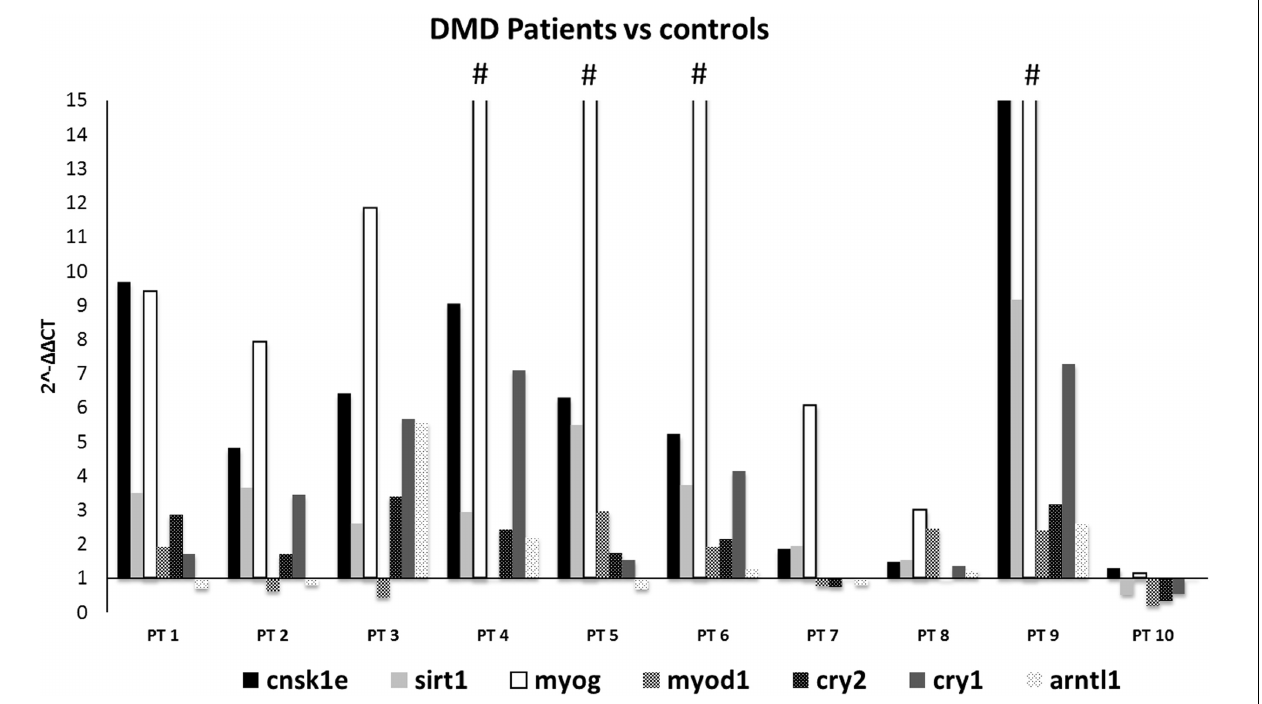
FIGURE 2 | Expression profiling of 7 deregulated genes in muscle samples from DMD patients ( n = 10). Note the great upregulation of MYOG. (#): indicates that the expression level of MYOG is more than 15-fold, in PT4:25, PT5:34.7, PT6:43, and PT9:34.7. CSNK1E, SIRT1, and MYOG genes were significantly upregulated in all DMD muscles except for PT8 and